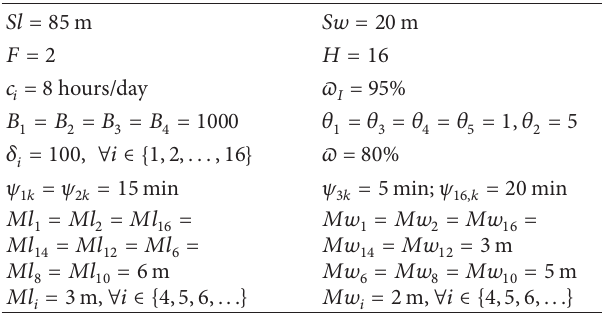
Table 1: Other data involved in the dynamic facility layout problem.